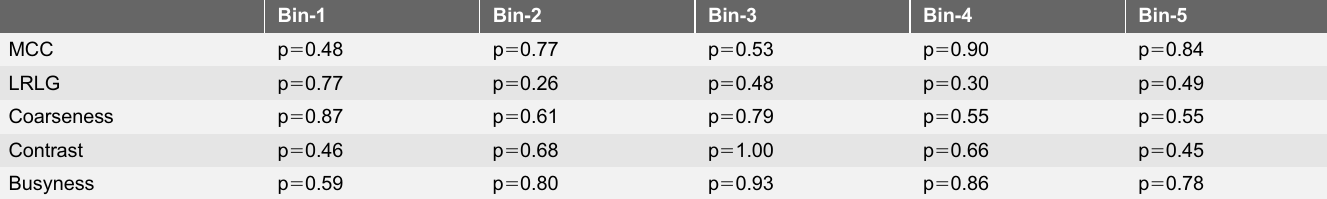
Table 3. p-values for the comparison of d 3D-4D between adenocarcinoma and squamous cell carcinoma using Mann-Whitney